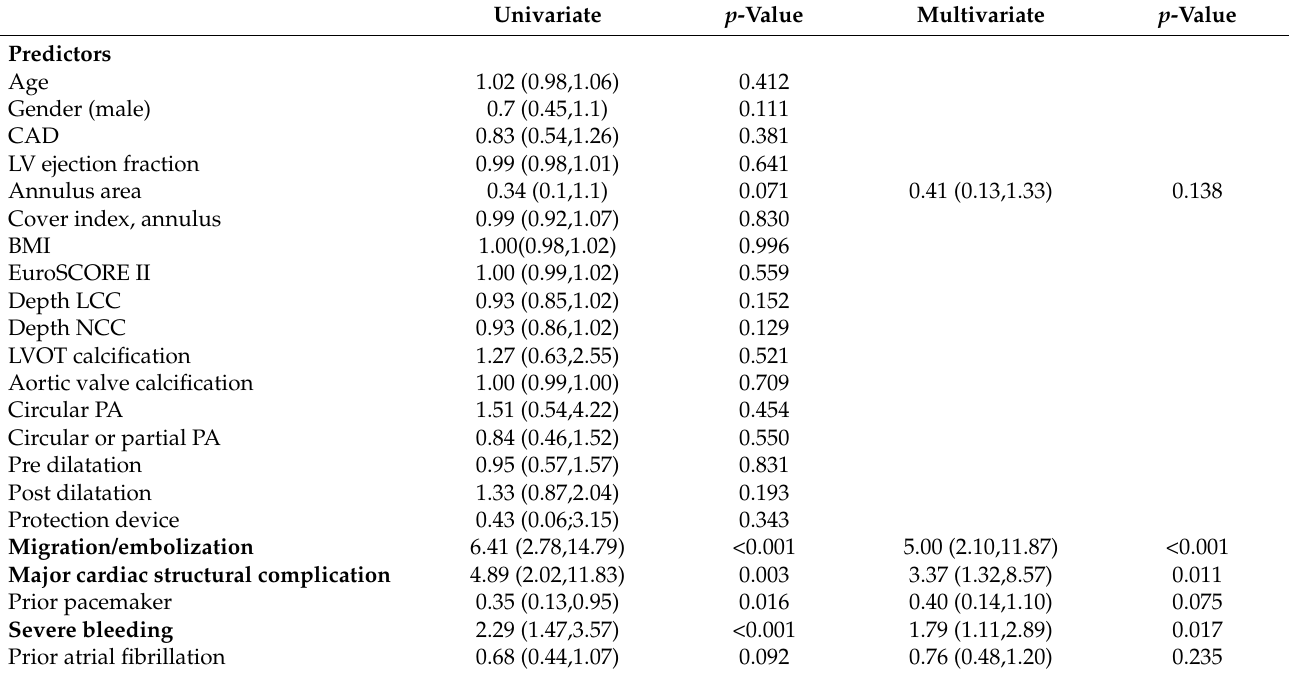
Table 4. Predictors for stroke (in-hospital).